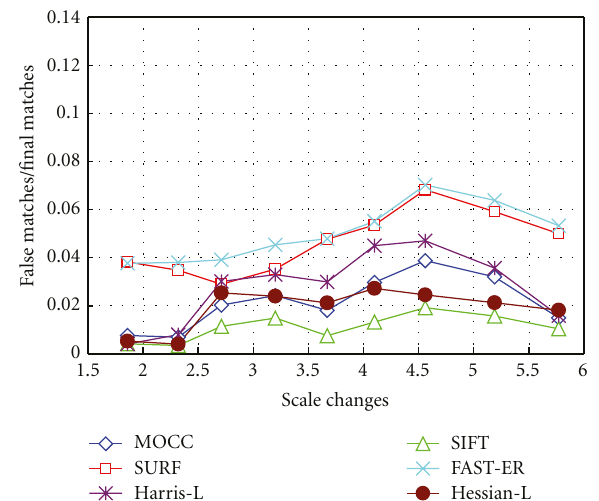
Figure 17: Matching results on images with illumination changes (Leuven